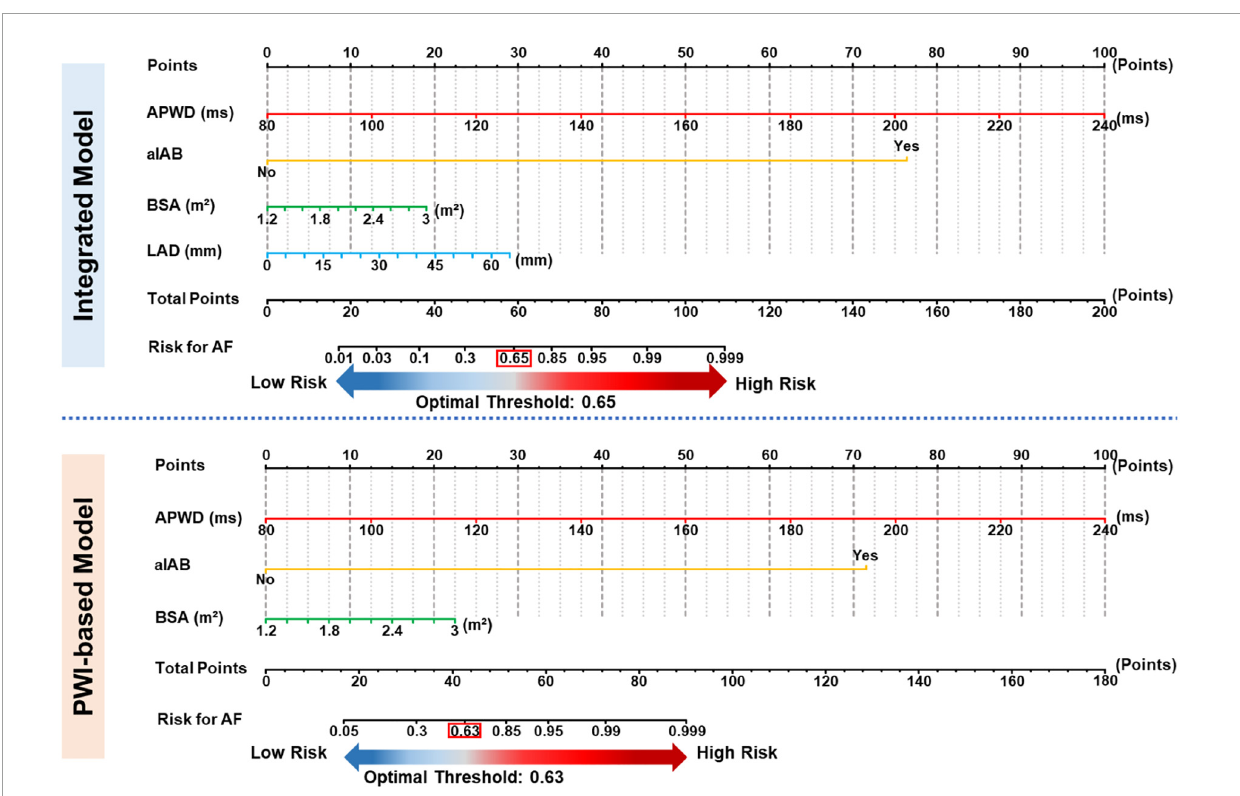
FIGURE5 Nomograms for identification of AF patients. Nomogram of PWI-based model (upper panel) and Integrated model (lower panel) . Each value from respective scale corresponds to a specific value at the top points scale, and the total points correspond to the estimated risk (bottom scale) for AF by respective model. APWD, duration of amplified p-wave; aIAB, advanced inter-atrial block; BSA, body surface area; LAD, left atrial diameter.